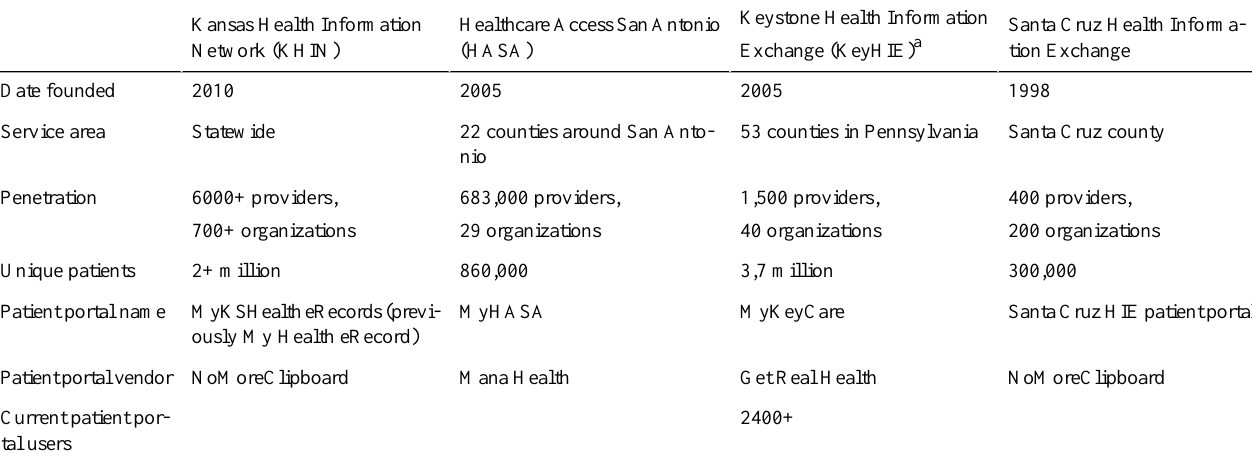
Table 1. Characteristics of HIEs implementing patient